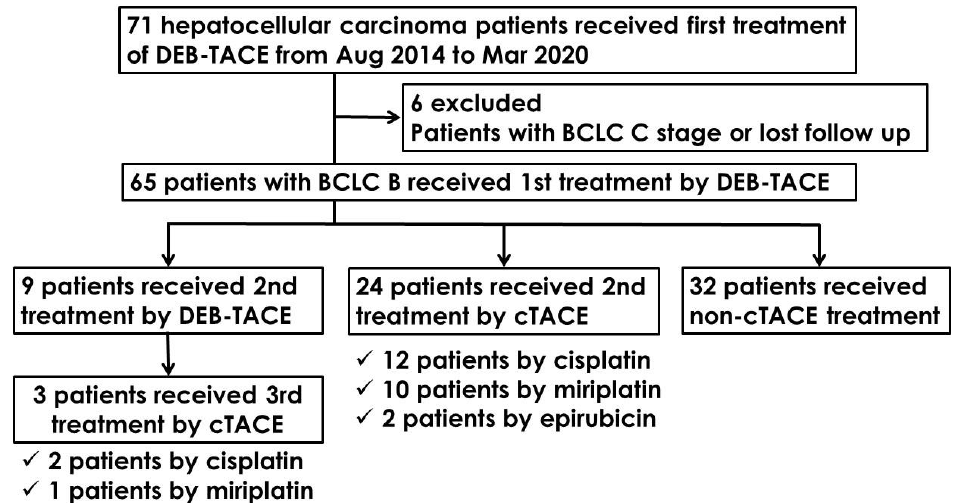
Figure 1. Flow chart of treatment received by the 65 patients enrolled in our study.